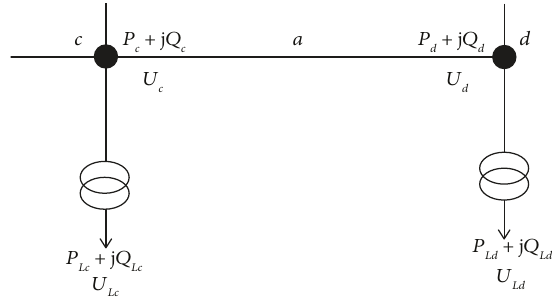
Figure 1: Power flow calculation circuit